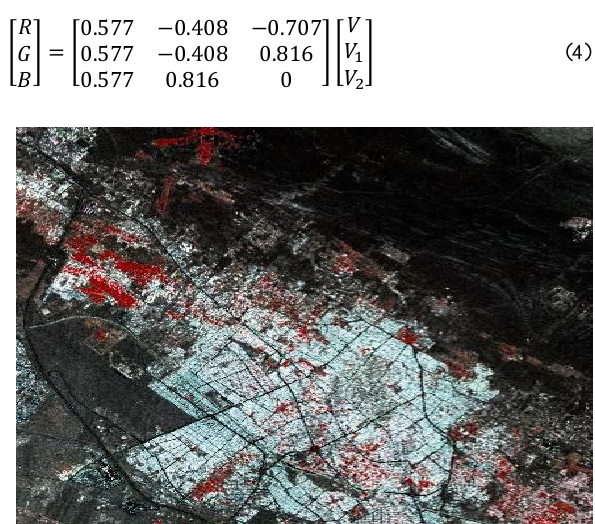
Figure 8. Data fusion, HSV